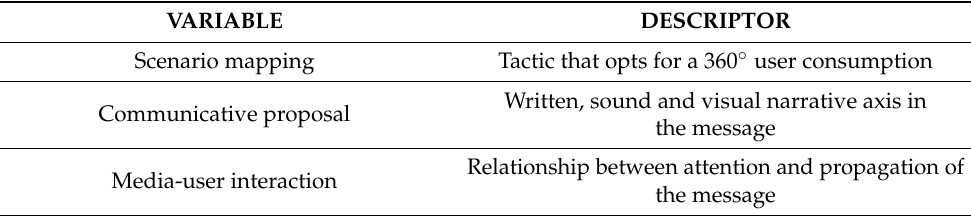
Table 4. Quantitative analysis categories used in performance analysis on social